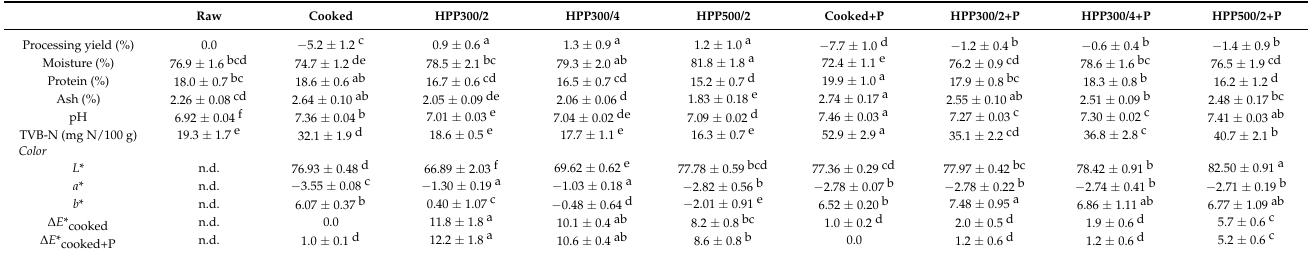
Note. Results are expressed as mean values ( ± standard deviation); n.d. = not determined. Different superscript letters within the same row indicate significantly different ( p < 0.05) mean values. Sample codes: HPP300/2 and HPP300/4, high-pressure processed at 300 MPa for 2 and 4 min, respectively; HPP500/2, high-pressure processed at 500 MPa for 2 min; +P, thermal pasteurization after cooking or high-pressure